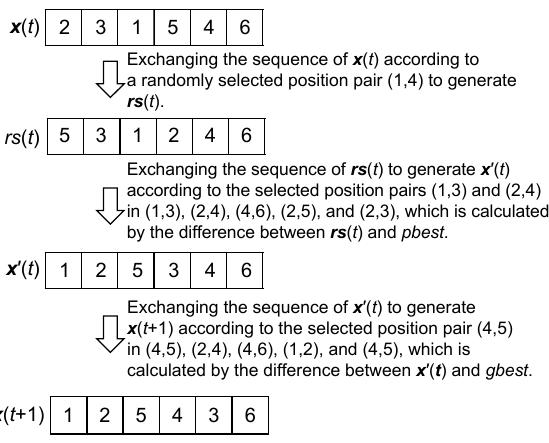
Fig. 4 Division of the particle swarm by direction. Fig. 5 Update process of PSO with the exchange